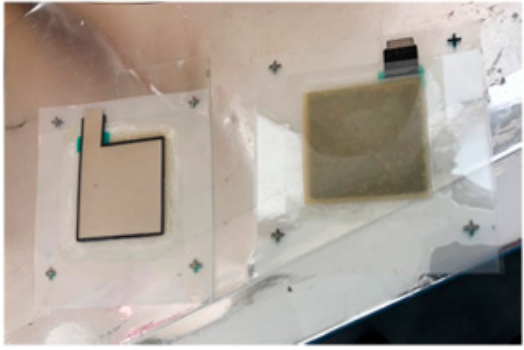
Figure 2. Manufactured dye-sensitized solar cells.